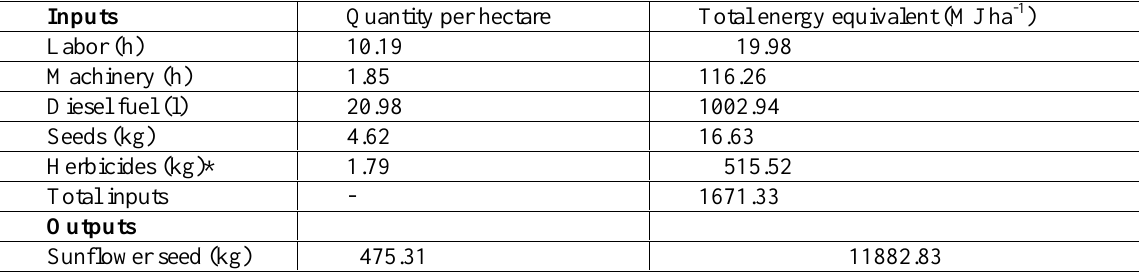
Table 4. Amount of inputs, outputs and their energy equivalent for sunflower production in the mechanized rain fed schemes e in astern Sudan Inputs Quantity per hectare Total energy equivalent (MJ ha -1 )